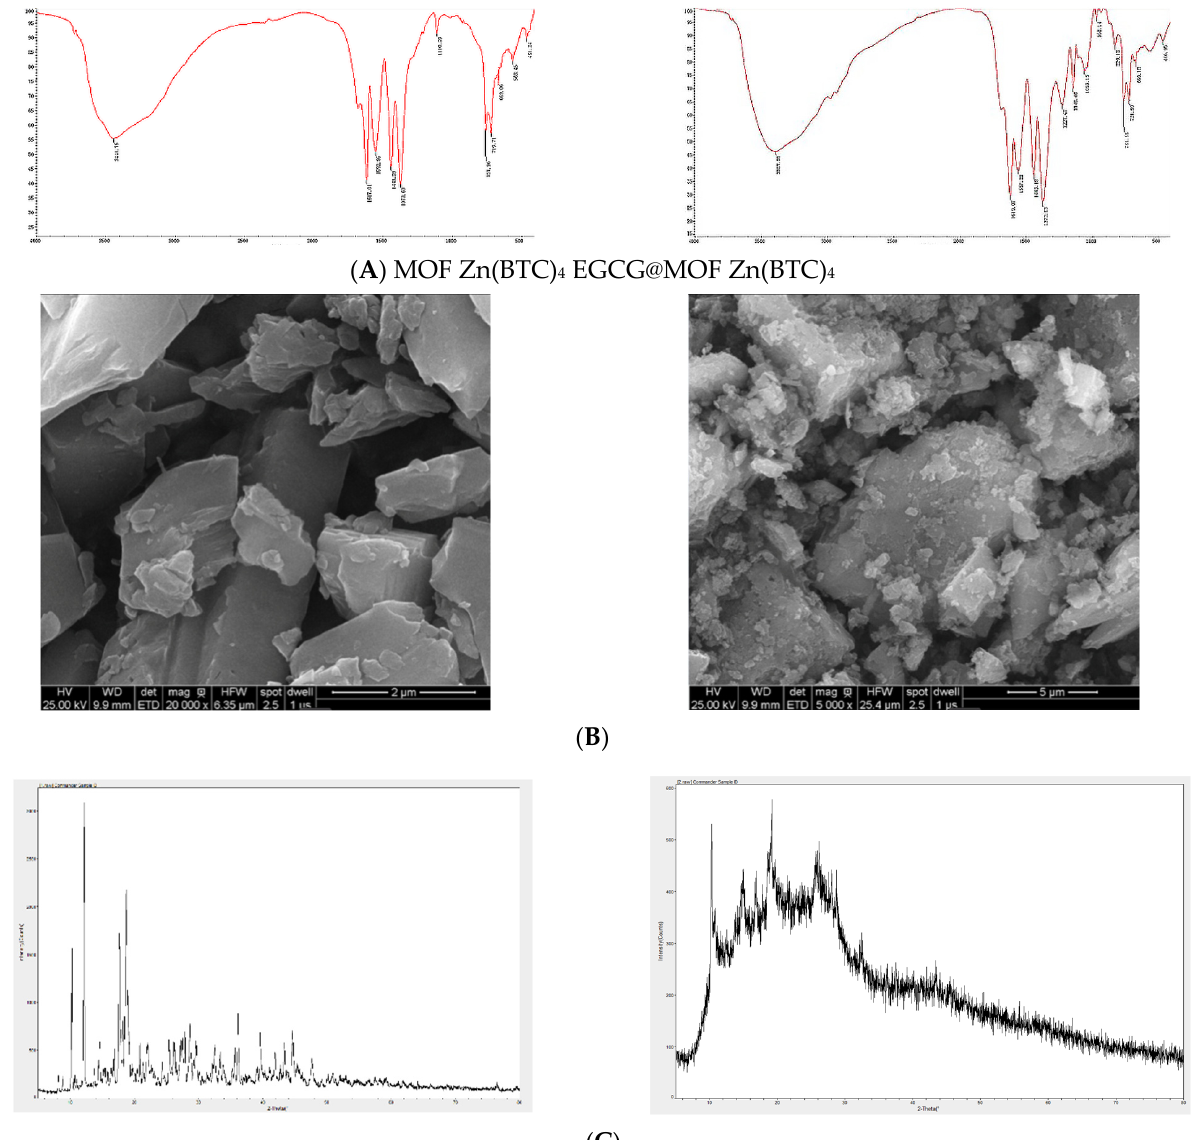
Figure 5. Comparison of MOF Zn(BTC) 4 and EGCG@MOF Zn(BTC) 4. ( A ) IR spectroscopy analysis of MOF Zn(BTC) 4 and EGCG@MOF Zn(BTC) 4 ; ( B ) Scanning electron microscopy (SEM) of MOF Zn(BTC) 4 and EGCG@MOF Zn(BTC) 4 ; ( C ) X-ray diffraction (XRD) analysis of MOF Zn(BTC) 4 EGCG @ MOF Zn(BTC) 4. MOF Zn(BTC) 4 and EGCG@MOF Zn(BTC) 4 morphologies were assessed by scanning